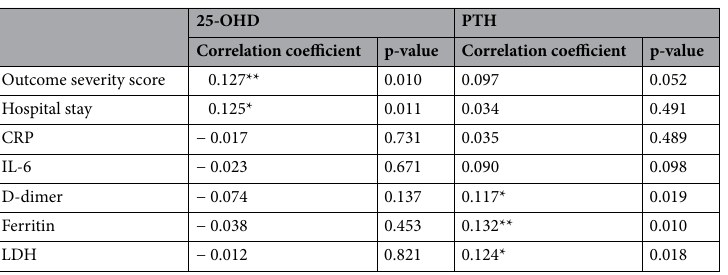
Table 4. Correlation of 25-OHD and PTH with outcome severity scores and inflammatory markers in hospitalized COVID-19 patients. **Correlation is significant at the 0.01 level (2-tailed). *Correlation is significant at the 0.05 level